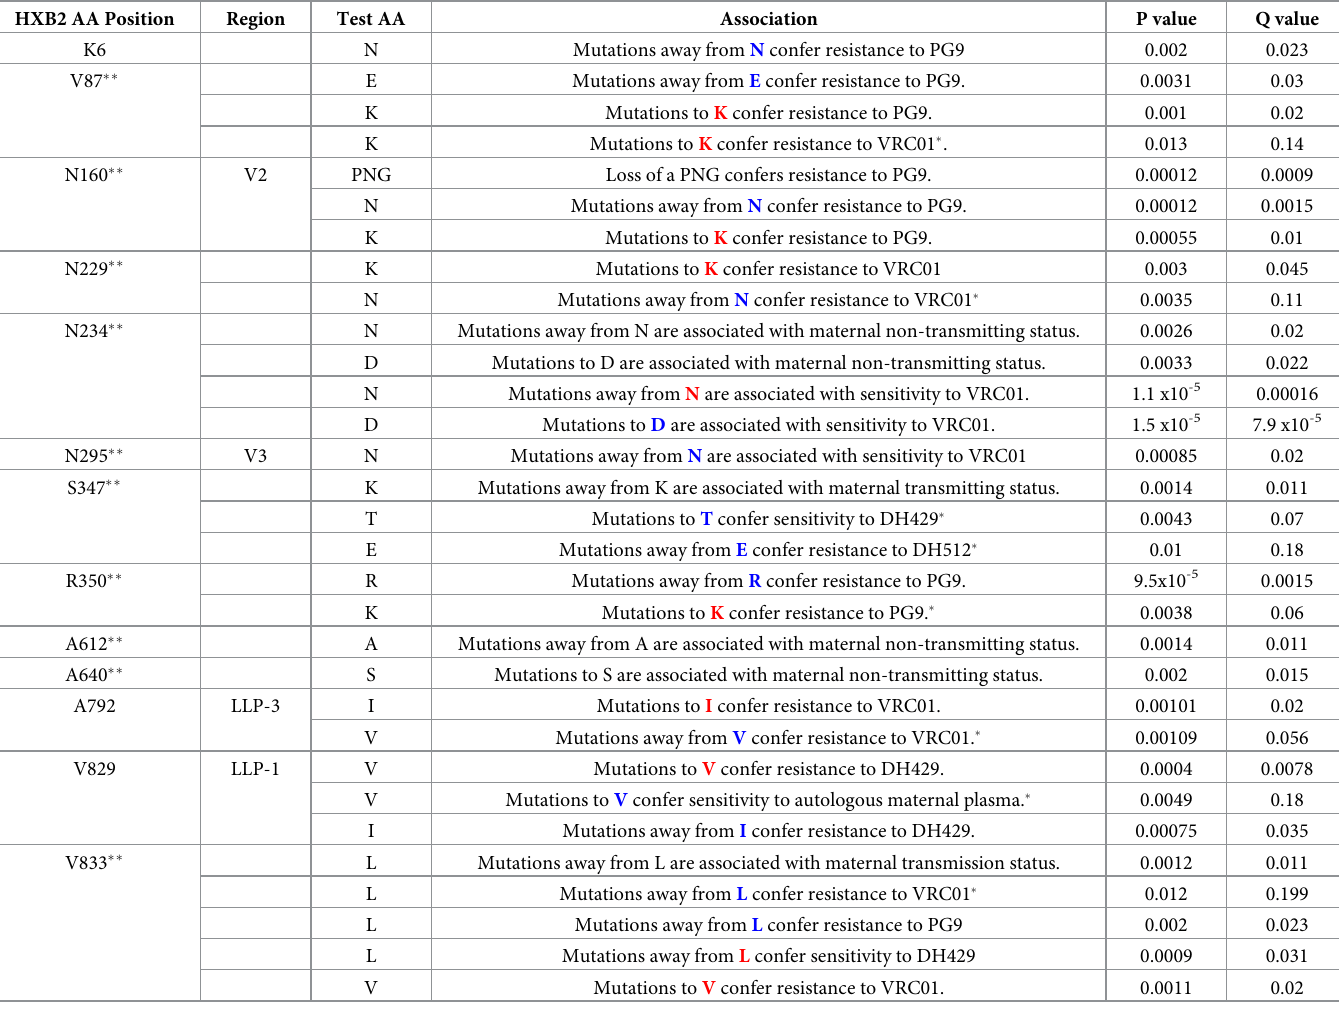
Similarly, at site V833, mutations away from amino acid L were associated with resistance to both PG9 and VRC01 while at the same time they were associated with transmission status (Fig 5). Interestingly, all infant TF Envs had a PNG at position 234, and 19 out of 23 infant TFs carried amino acid L at position 833. Taken together, these findings suggest that acquired resistance to bnAbs may play a role in selecting for variants that are also fit for vertical trans- mission. Additional studies will be needed to determine whether this bnAb resistance pheno- type could be a more important risk factor for transmission than resistance to autologous plasma neutralization.